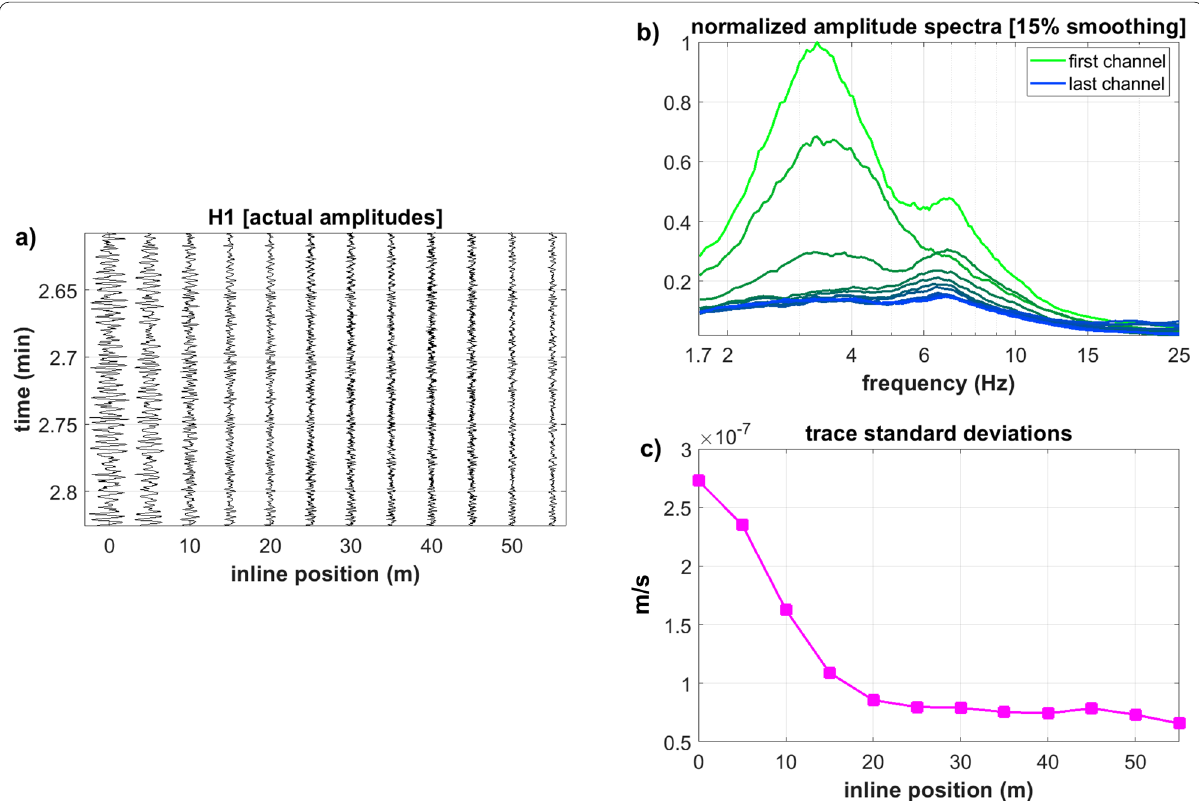
Fig. 18 Beligna#1—multi-offset passive data (T component): a small part of the recorded traces (14 s window); b normalized mean amplitude spectra (15% spectral smoothing) (color changes from green to blue as we move along the array); c standard deviations computed for all the twelve traces. The larger amplitude of the first traces is apparent from all the three graphs (three different ways to assess the mean microtremor